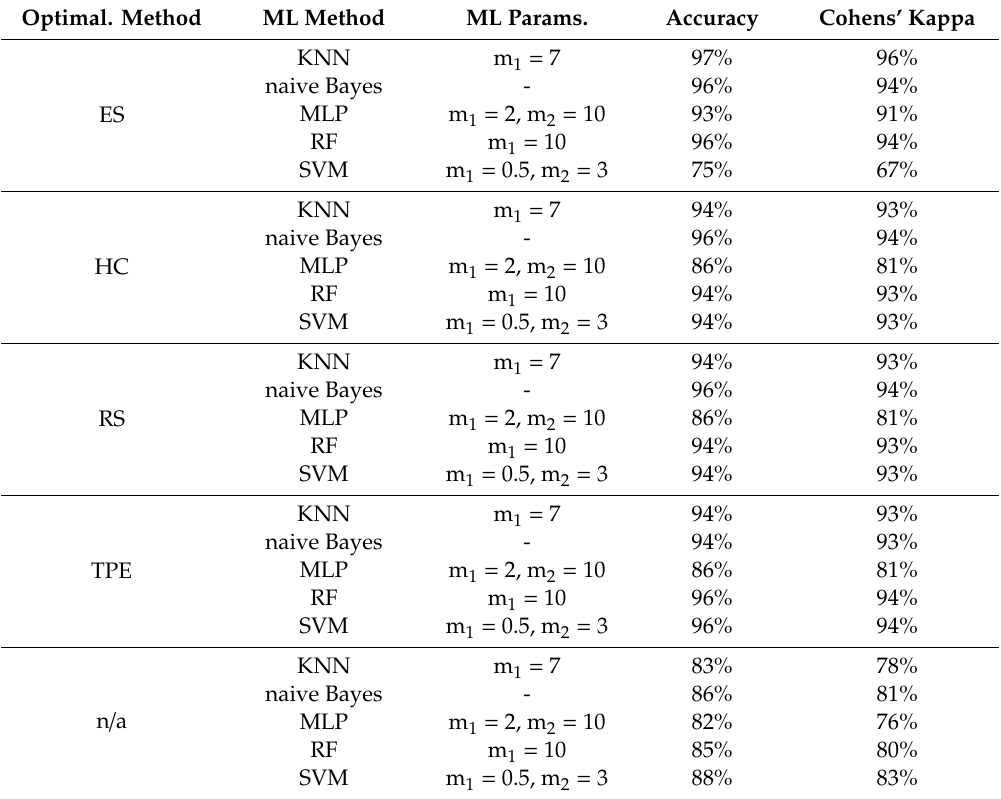
Table 4. Comparison of various machine learning